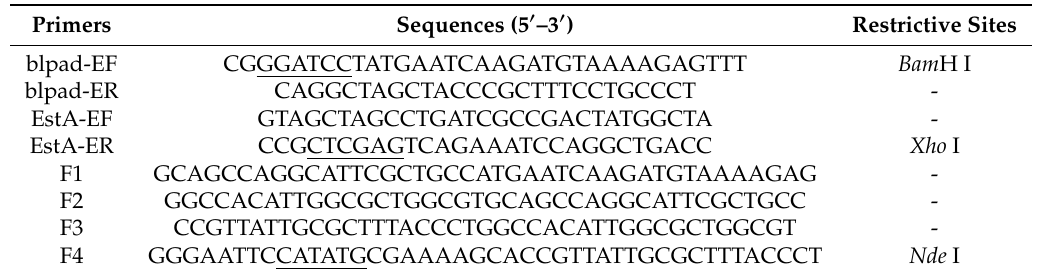
Table 2. Oligonucleotide primers used in this